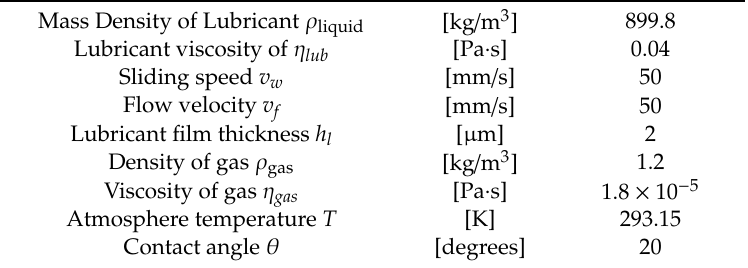
Table 4. Analytical conditions for the laminar two-phase flow analysis.